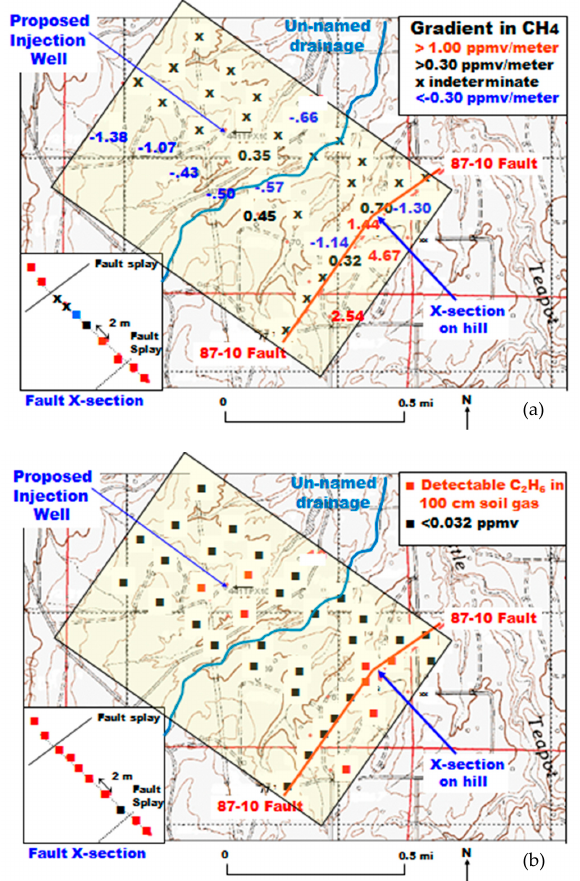
Figure 15. Methane gradient ( a ) and ethane detection ( b ) in a focused study in Section 10 and Fault Zone 1.